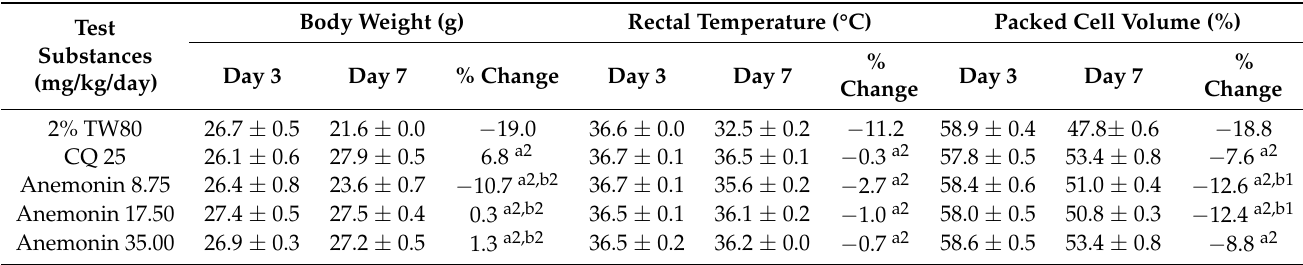
Table 9. Body weight, rectal temperature, and packed cell volume of Plasmodium berghei -infected mice treated with anemonin in prophylactic antimalarial test.